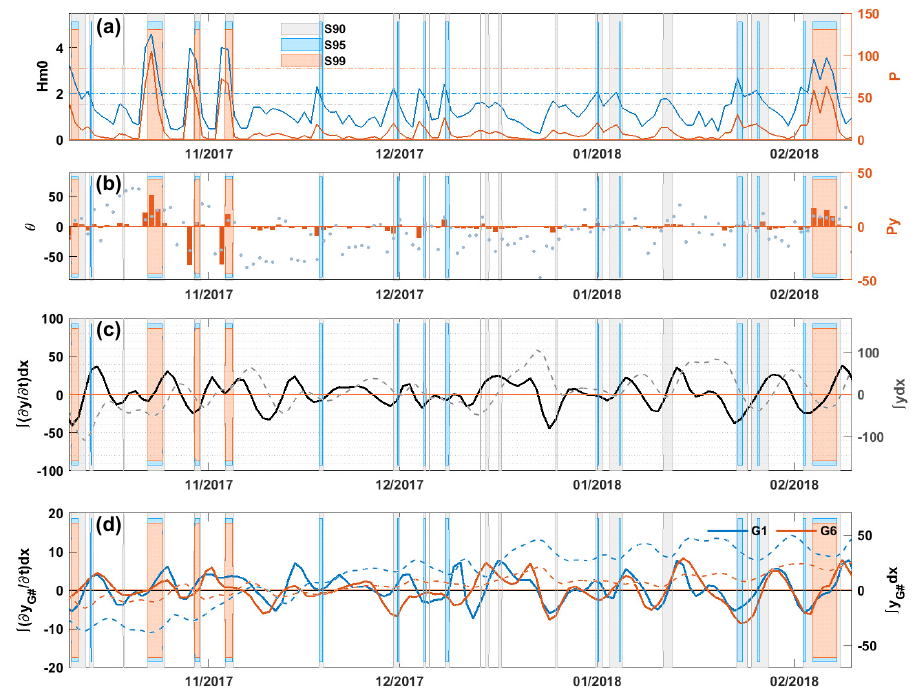
Figure 8. Changes in wave characteristics and beach width during the winter between 2016 and 2017. ( a ) Significant wave height and wave power, ( b ) wave direction and longshore component of wave power, ( c ) longshore transport rate (solid line) and integrated beach width (dashed line), and ( d ) longshore transport rate (solid line) and integrated beach width for sectors G1 and G6 (dashed line).